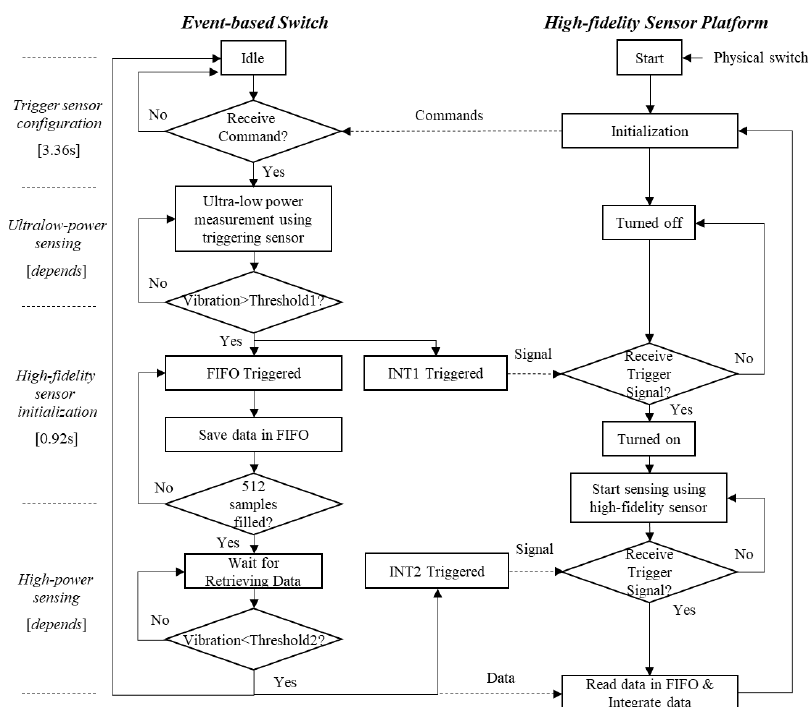
Figure 4. Flowchart of demand-based wireless smart sensors (WSS) for event-triggered sensing.